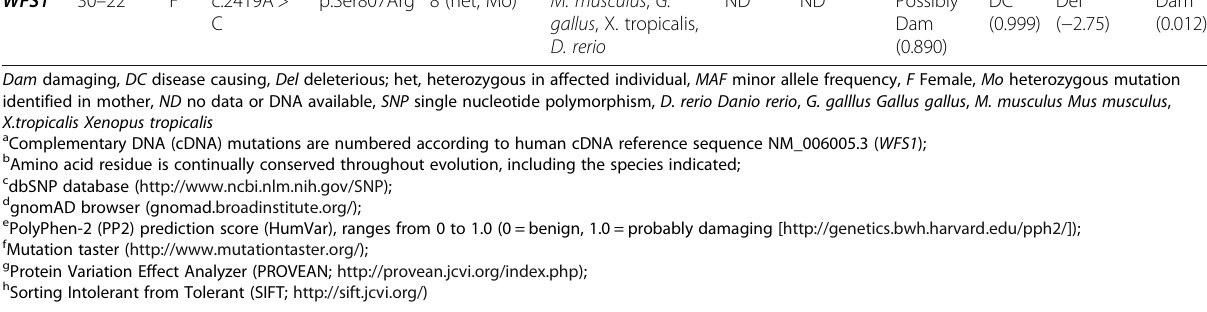
Table 2 Mutation candidates identified by whole exome sequencing Gene Individual Sex Nucleotide Symbol change